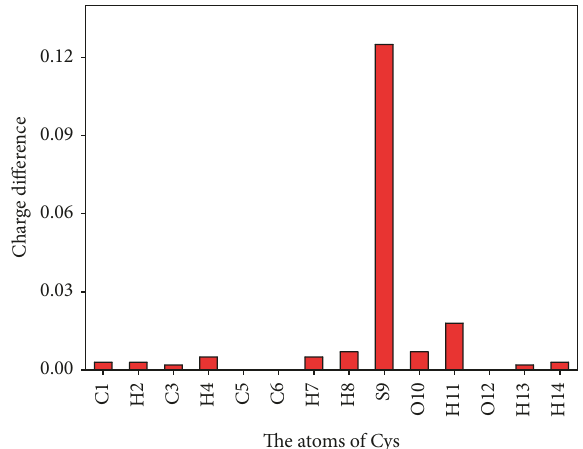
Figure 5: The charge difference of each atom of Cys.